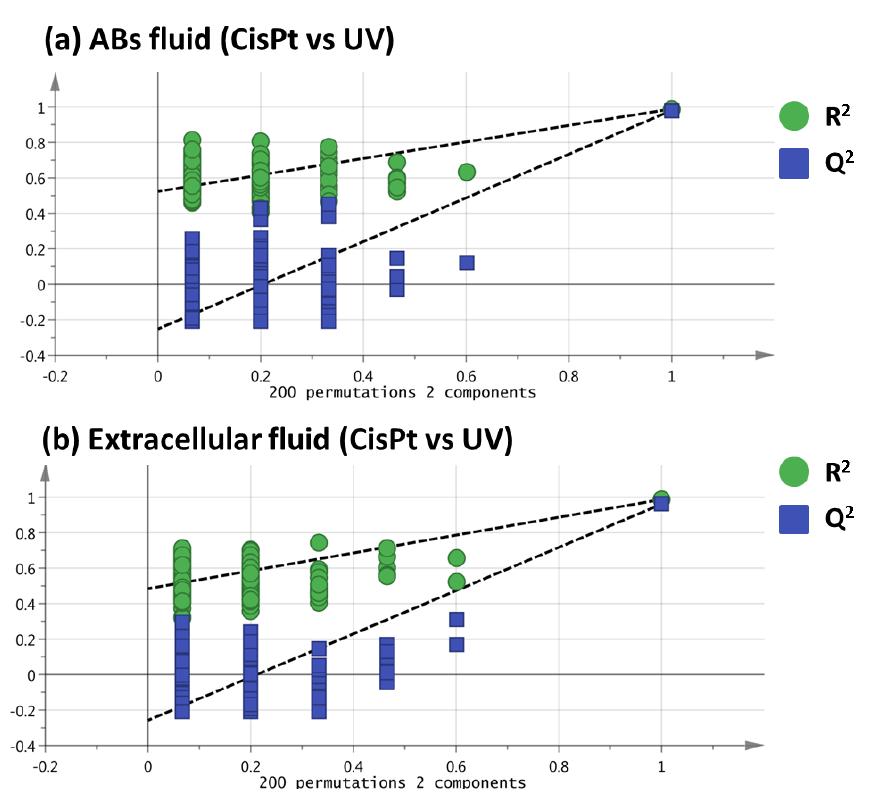
Figure 3. Permutation tests for the comparison of Cispt vs. UV of ABs fluid ( a ) and extracellular fluid ( b ) analyses.